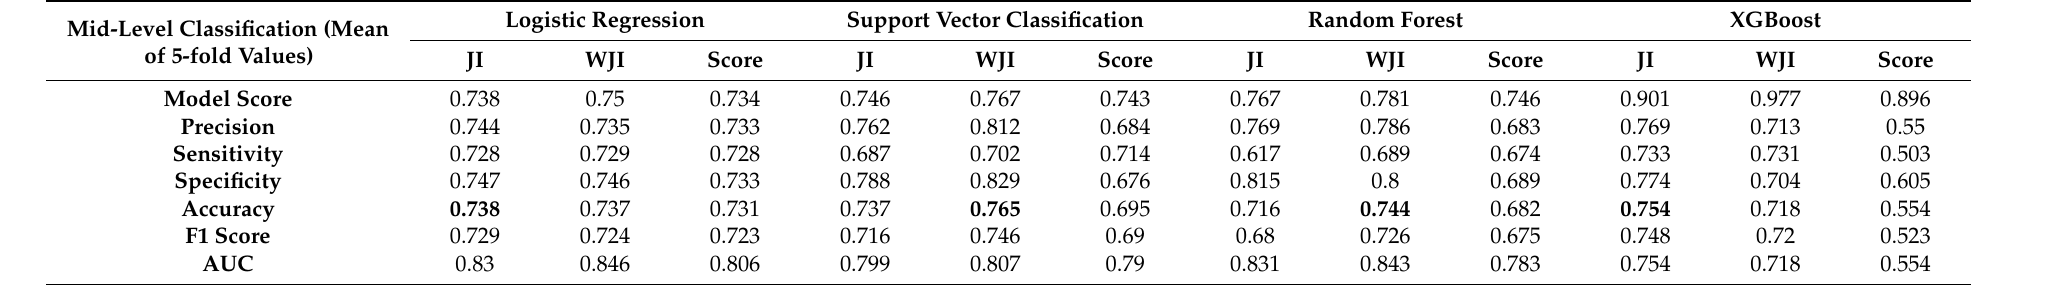
Table 10. Training and verification results of ALS_EG , ALS_CG and ALS_SELECT_FEA 0.1 (mid-level